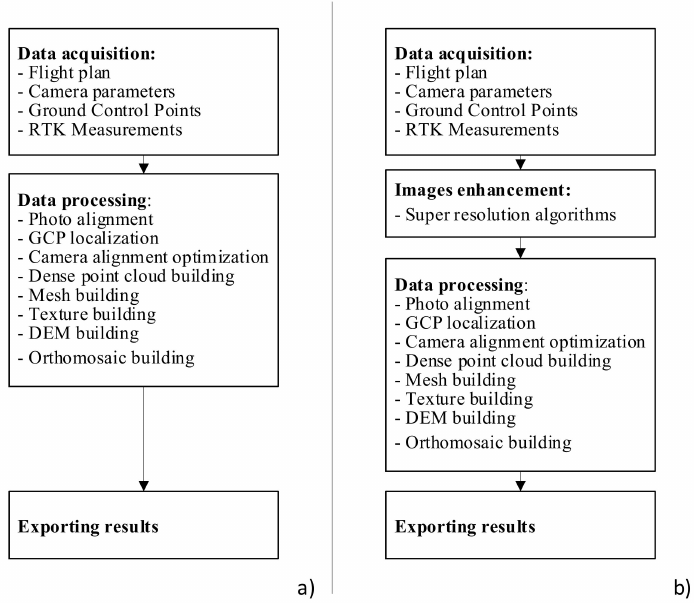
Figure 1. Traditional unmanned aerial vehicle (UAV) photogrammetric process ( a ) and augmented by a super-resolution algorithm ( b ). GCP: ground-control points and RTK: real-time